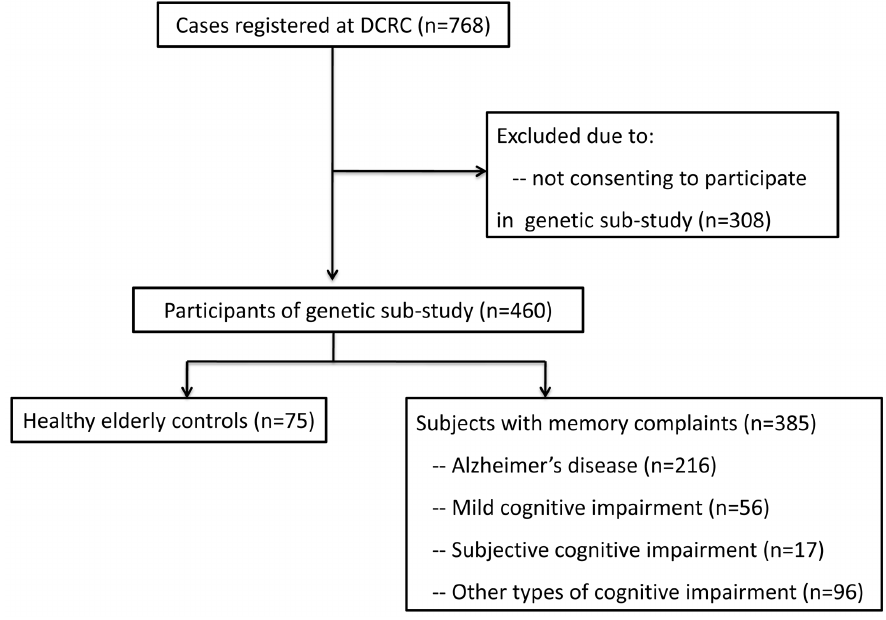
Figure 1. Flow chart of subject recruitment and selection for the genetic sub-study.